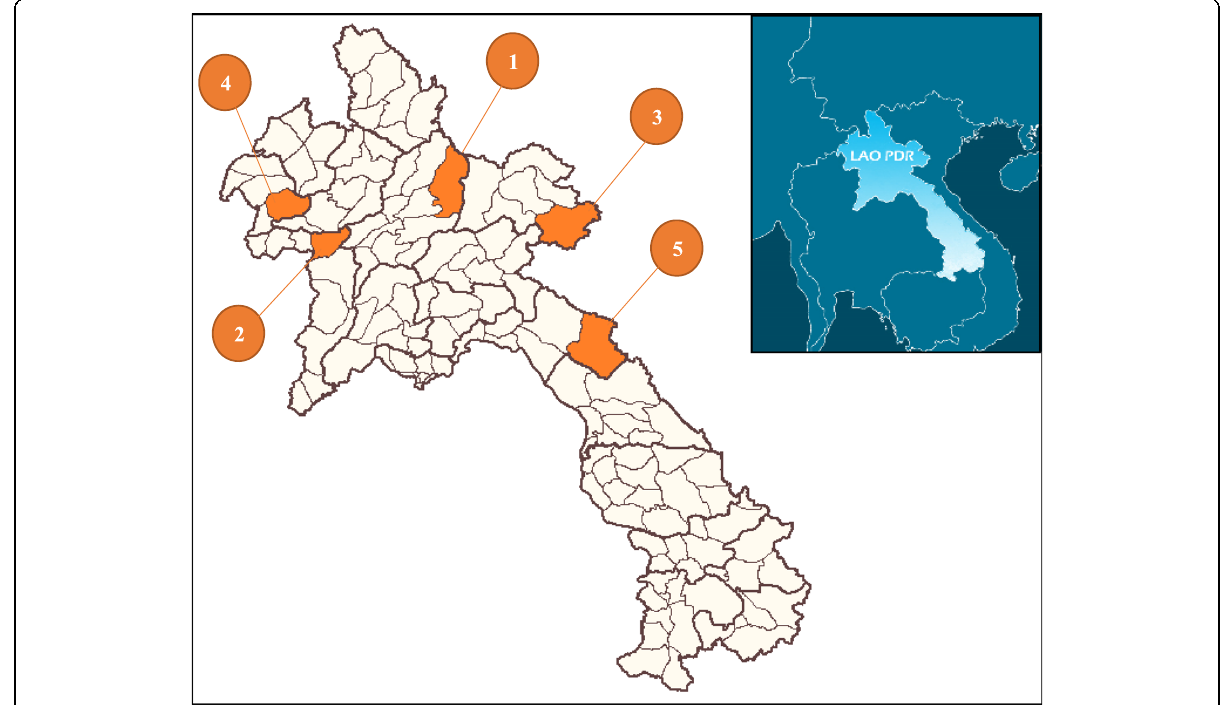
Fig. 1 The location of the Lao PDR and study areas. The study included (1) Viengkam District, Laung Prabang Province, (2) Hongsa District, Xayaboury Province, (3) Xamtai District, Houaphanh Province, (4) Pha Udom District, Bokeo Province, (5) Khamkuet District, Bolikhamxay